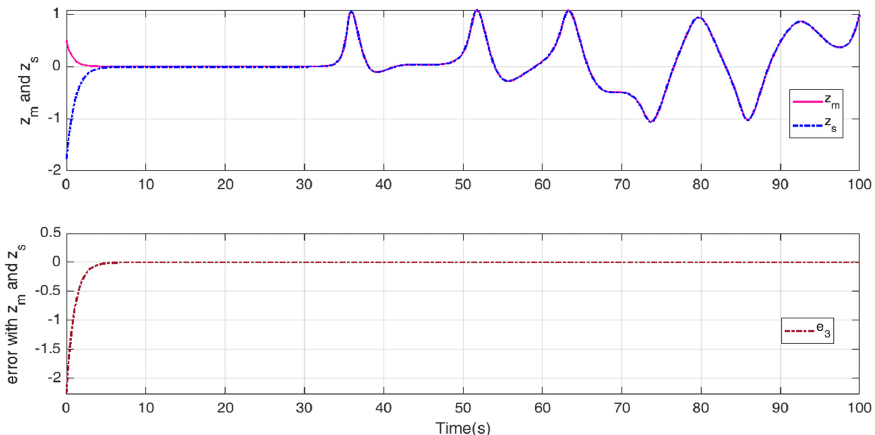
Figure 8. The master–slave synchronization of the third state.